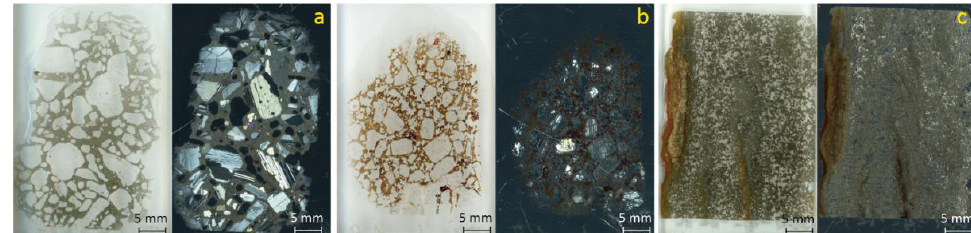
Figure 10. Thin section scans in LPA and LPNA from site 4. ( a ) Porphyritic basalt with plagioclase DJI-4-13. ( b ) Altered porphyritic basalt with plagioclases DJI-4-1. ( c ) Aphyric lava DJI-4-12.